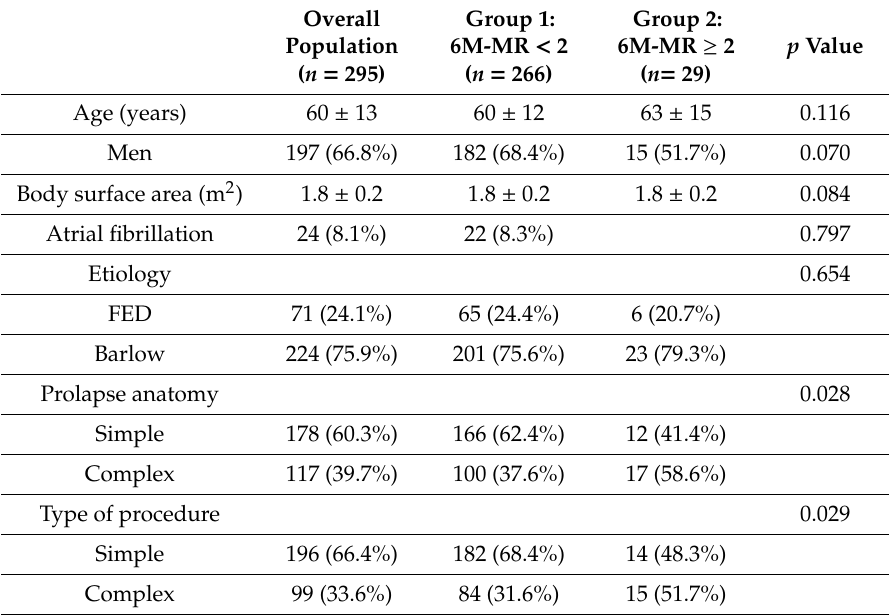
Table 1. Mean ± SD and / or frequencies of baseline clinical characteristics of the study population.